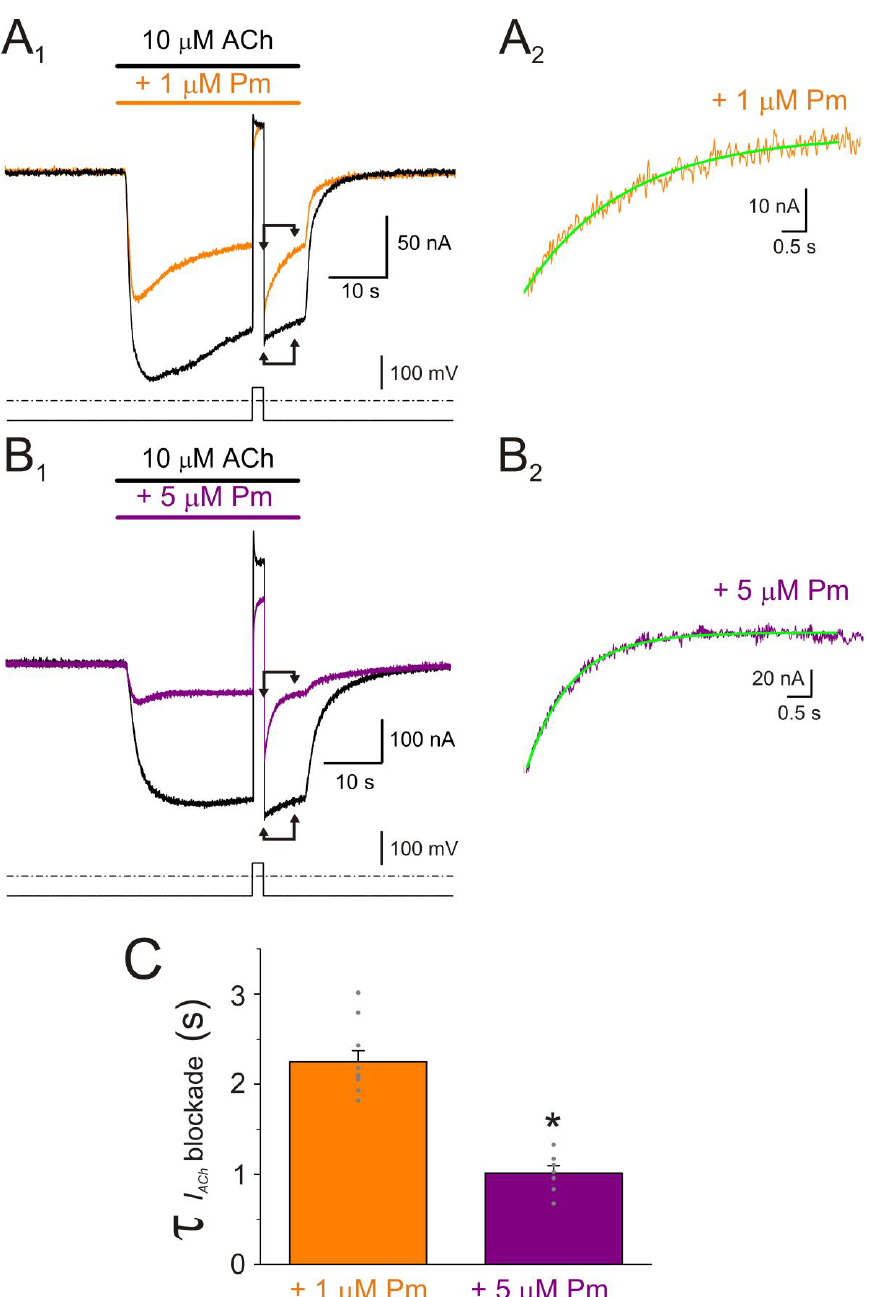
Fig.7 Figure 7. Kinetics of the voltage-dependent blockade of nAChR by Pm. ( A 1 , B 1 ) I ACh s elicited by 10 µ M ACh either alone (black recordings) or in the presence of 1 (orange; ( A 1 )) or 5 µ M (purple; ( B 1 )) Pm, at − 60 mV. A 2 s voltage jump to +40 mV was given at the I ACh plateau to unplug the channel pore of the positively-charged Pm. Membrane leak-currents (recorded in the absence of ACh) have been subtracted. ( A 2 , B 2 ) Zooming in to the area indicated by the arrows in panels ( A 1 , B 1 ) (just after the voltage jump). The τ of the voltage-dependent blockade of nAChRs by Pm was determined by fitting an exponential function (green curve over the recording) to the net I ACh decay. Before fitting, the smaller and slower I ACh s evoked by ACh alone (black recordings of panels ( A 1 , B 1 )) were subtracted from the I ACh s in the presence of Pm. ( C ) Column-graph of τ values of the voltage-dependent blockade of nAChR by 1 and 5 µ M Pm (same color code as in panels ( A , B )). (*) indicates significant differences of τ values between both Pm concentrations ( p < 0.05, t -test). Data are for 10 ( N = 3) and 7 ( N = 2) oocytes for 1 µ M and 5 µ M Pm,